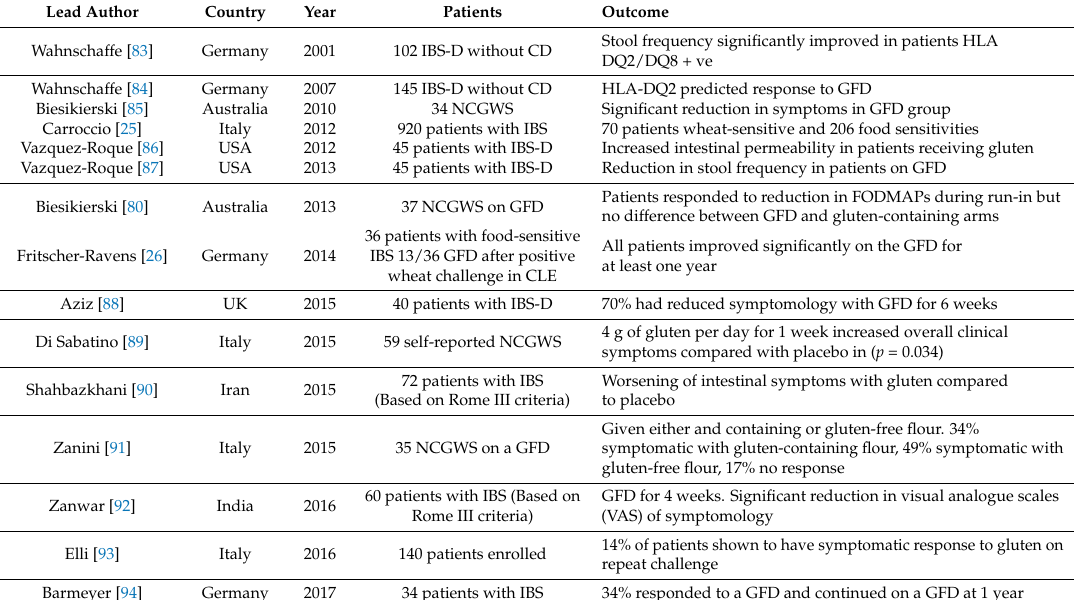
Table 2. Summary of studies examining the role of gluten and wheat in